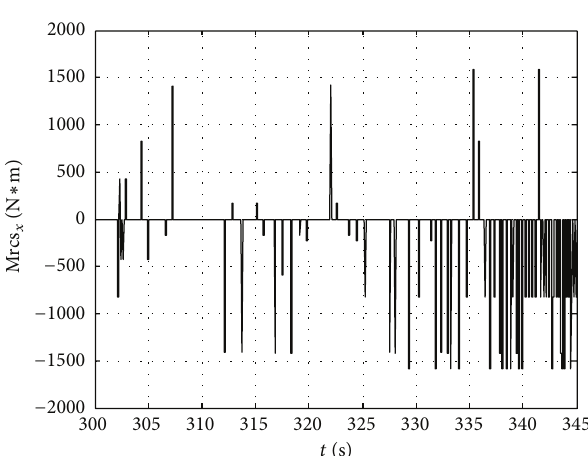
Figure 23: Simulation result of RCS pitch moment.